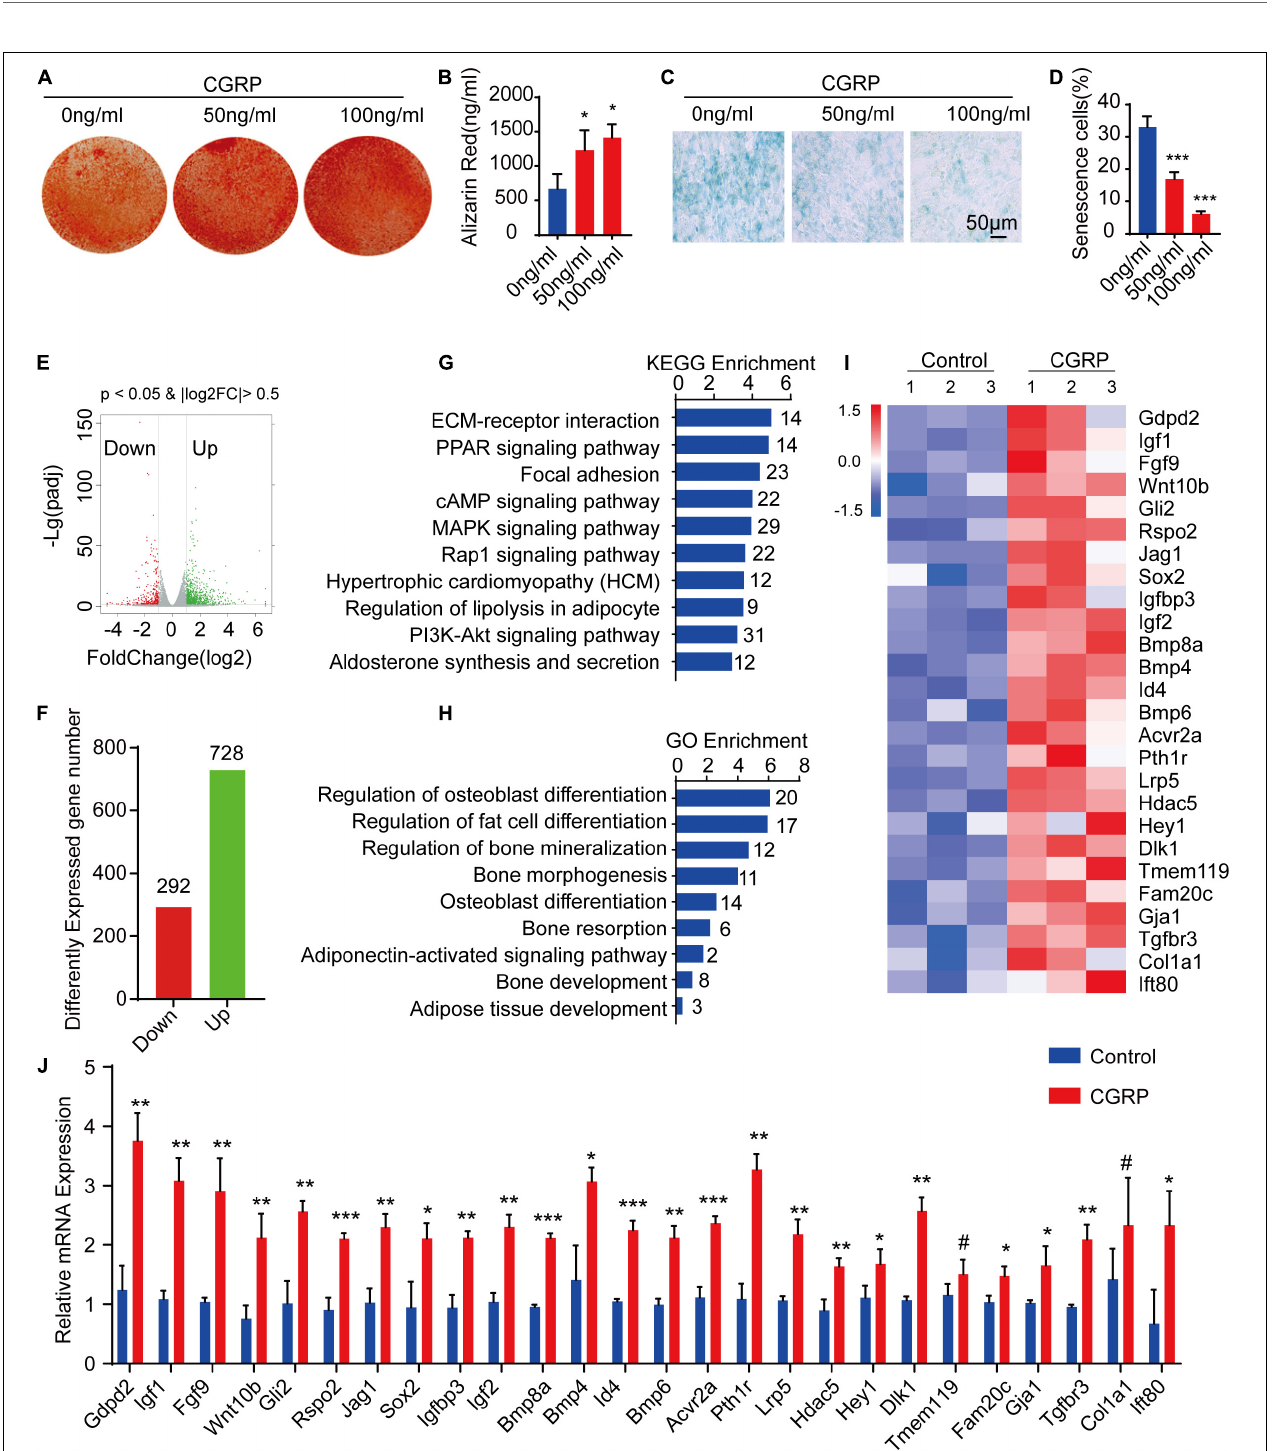
FIGURE 2 | CGRP induced the osteogenic differentiation of bone marrow-derived stem cells (BMSCs) and reduced BMSC senescence. (A) Representative images of Alizarin Red staining and (B) quantitative analysis of matrix mineralization in BMSCs treated with or without CGRP. (C) Representative images of beta-galactosidase staining and (D) quantitative analysis of the percentage of senescent cells in BMSCs treated with or without CGRP. (E) Volcano map and (F) histogram of differentially expressed genes between the CGRP treatment and control groups. Red spots represent downregulated genes and green spots represent upregulated genes. (G) Enrichment of differentially expressed genes was tested using Kyoto Encyclopedia of Genes and Genomes (KEGG) pathway analysis and (H) Gene Ontology (GO) analysis. (I) A heatmap of the mRNA-seq profile of BMSCs treated with or without CGRP. Fold-change ≥ 2.0. (J) RT-qPCR analysis of gene expression levels in BMSCs treated with or without CGRP. Scale bar, 50 µ m. Data are presented as means ± SEM. * P < 0.05, ** P < 0.01,*** P < 0.001.